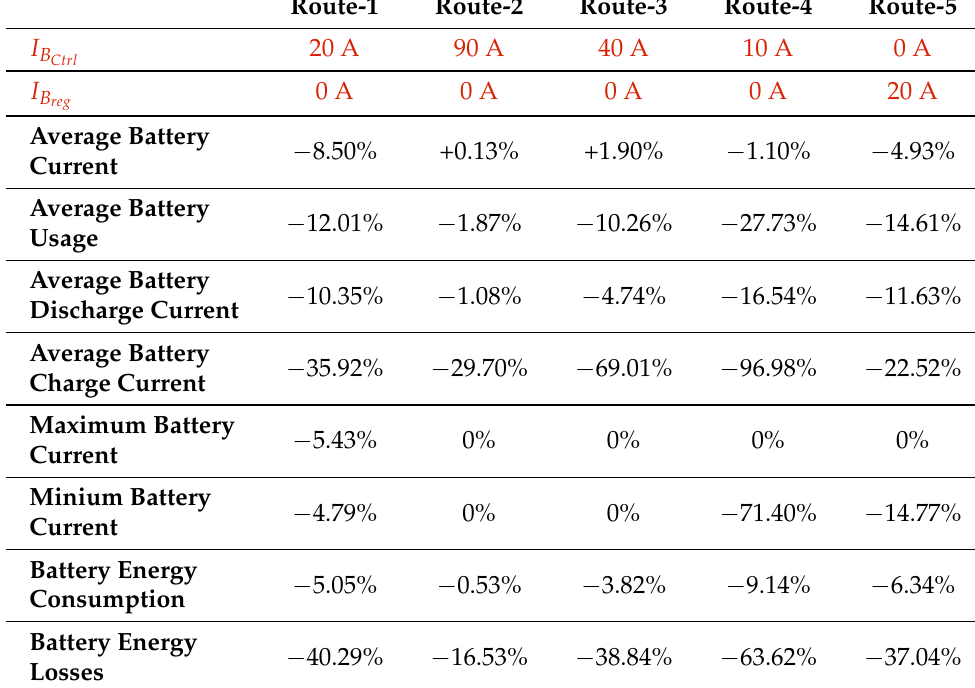
Table 3. Relative deviations between simulation of the battery and the HESS with energy management with route specific parametrisation to increase efficiency